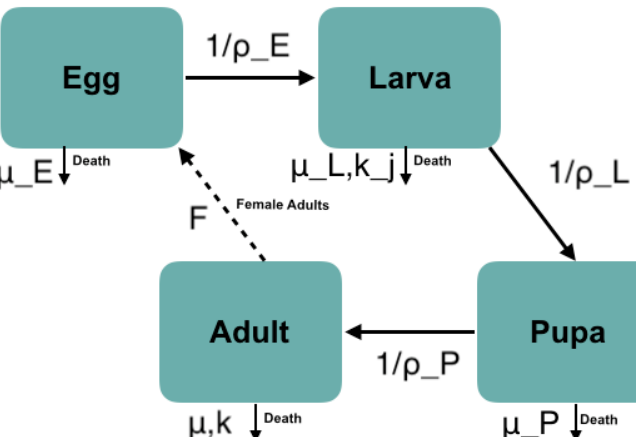
Figure 1. A graphical representation of the mosquito life cycle including eggs, larvae, pupae, and adults. Note that only female adults provide new eggs to the population, and the adult compartment represents just the female subclass. Arrows represent the movement between stages due to development, as well as the removal from the stage due to